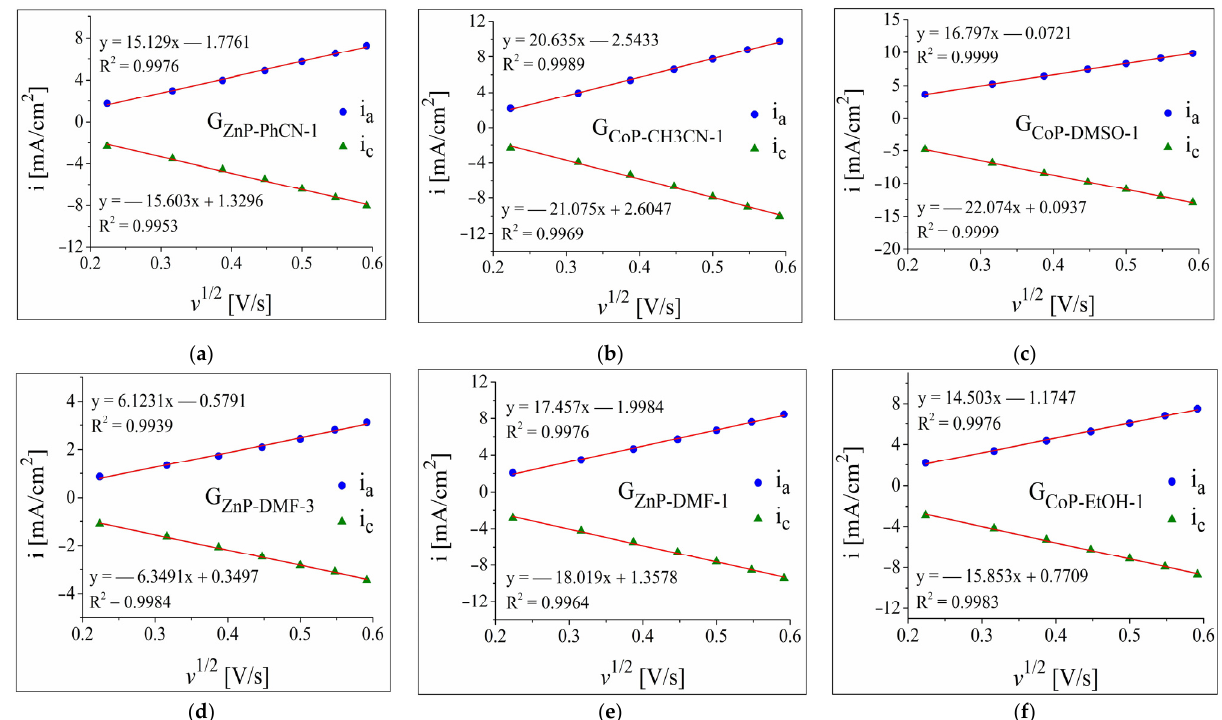
Figure 5. The plot of the anodic and cathodic peak current densities vs. the square root of the scan rate for the following electrodes: ( a ) G ZnP ‐ PhCN ‐ 1 , ( b ) G CoP ‐ CH3CN ‐ 1 , ( c ) G CoP ‐ DMSO ‐ 1 , ( d ) G ZnP ‐ DMF ‐ 3 , ( e ) G ZnP ‐ DMF ‐ 1 , and ( f ) G CoP ‐ EtOH ‐ 1 . The data were obtained from cyclic voltammograms recorded in 1 M KNO 3 solution containing 4 mM K 3 [Fe(CN) 6 ].